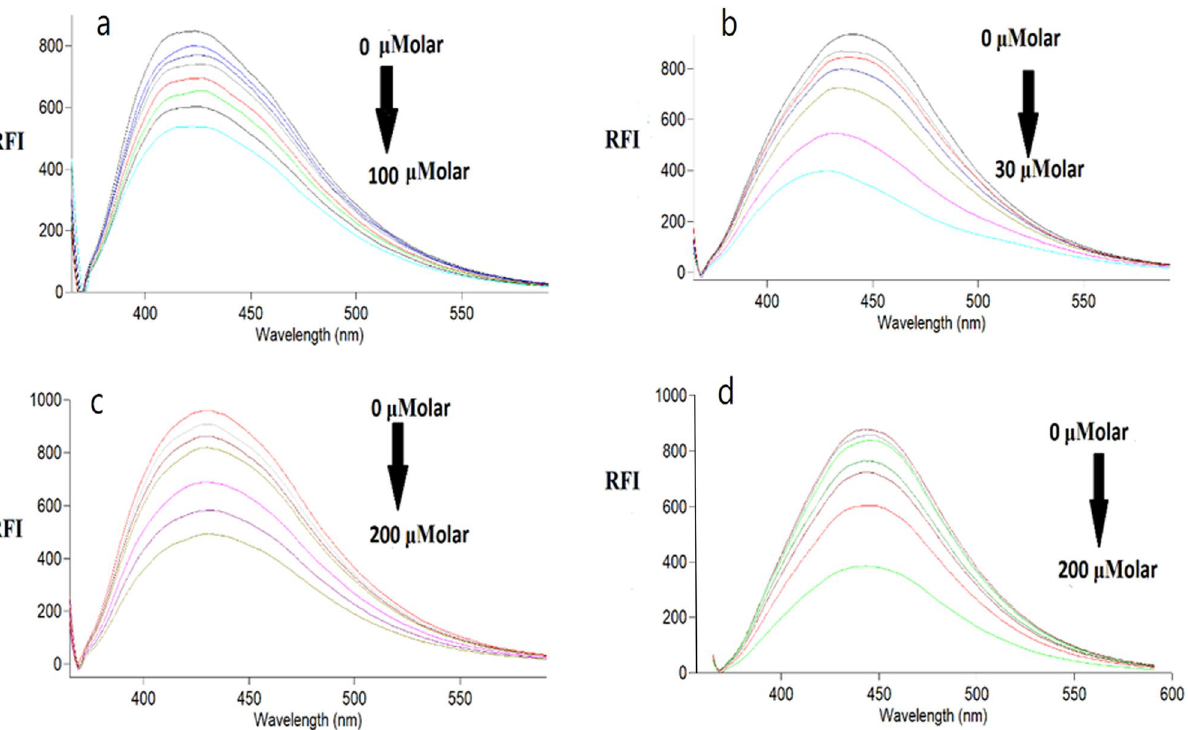
Figure 5. Fluorescence emission spectra of SN-CQDs in aqueous solution upon addition of various concentrations of ( a ) MNZ (from top to bottom: 0, 5.0, 10.0, 25.0, 40.0, 50.0, 75.0, 100.0 μM), ( b ) RFP(from top to bottom: 0, 1.0, 2.0, 5.0, 10.0 20.0, 30.0 μM), ( c ) TNZ (from top to bottom: 0, 10.0, 25.0, 50.0, 100.0, 150.0, 200.0 μM), and ( d ) ONZ (from top to bottom: 0, 6.0, 12.0, 25.0, 50.0, 100.0, 200.0